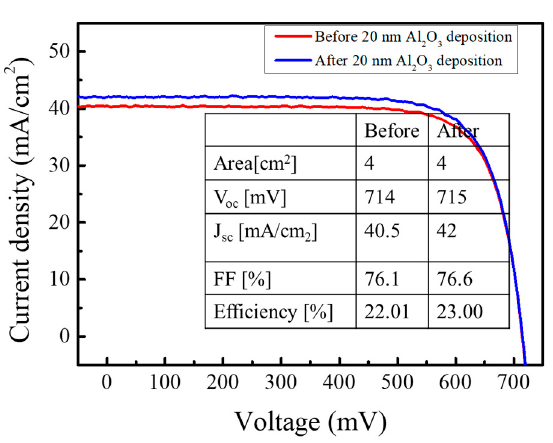
Figure 7. J–V curves of the SHJ solar cell before and after deposition of 15 nm Al2O3, with an Al2O3 layer.